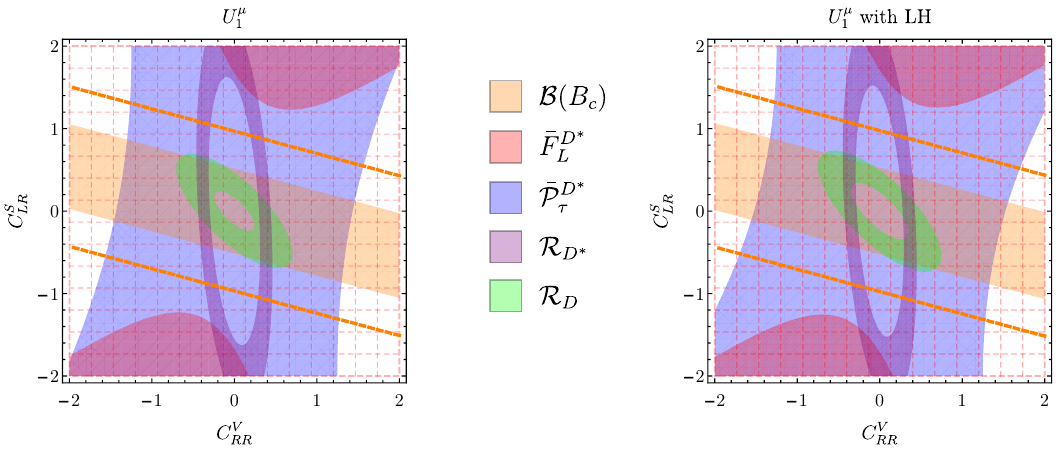
Figure 5 . Fit-independent plot of Scenario 5 , showing the regions allowed at 1 (cid:27) . On the left panel only the right handed neutrino Wilson coe(cid:14)cients are switched on ( Scenario 5a ), whereas on the right panel we set the LHN Wilson coe(cid:14)cients entering in Scenario 5b to their best-(cid:12)t values. The dashed orange line shows the more relaxed bound B ( B c ! (cid:28) (cid:22) (cid:23) ) (cid:20) 30%, and the red grid indicates the parameter space consistent with the experimental measurement of (cid:22) F D (cid:3)